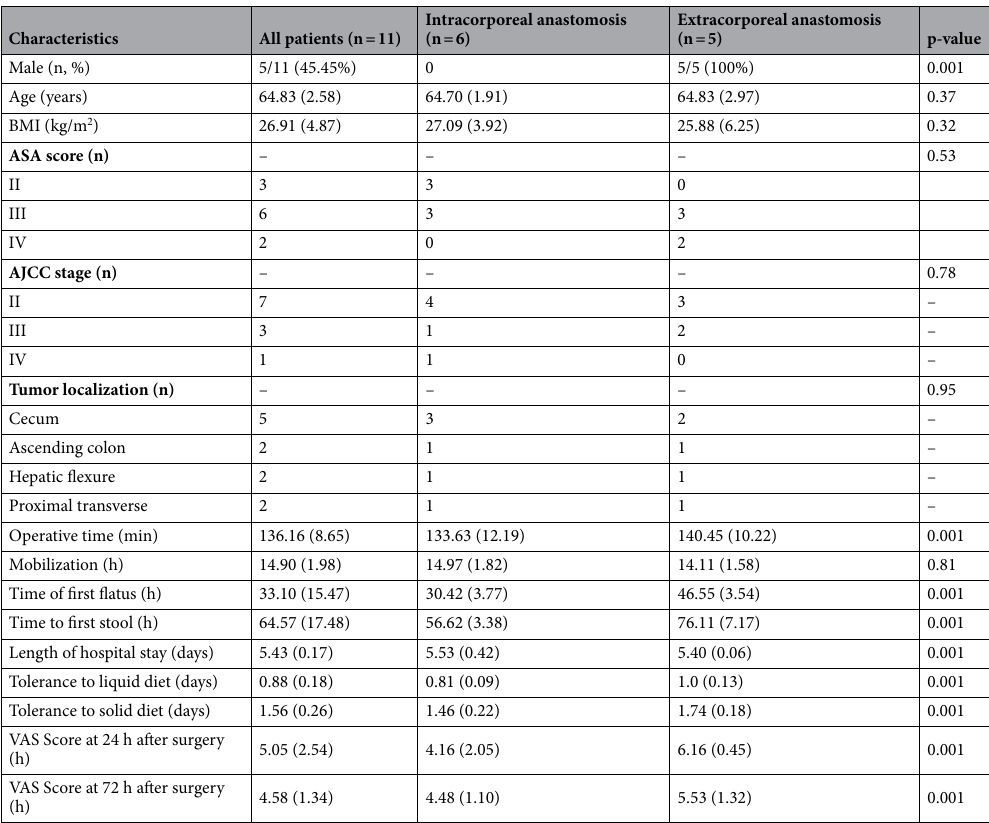
Table 5. Demographic characteristic and recovery outcomes of patients with post-operative complications. Data were expressed as median (interquartile range) where not differently indicated. BMI body mass index, ASA American Society of Anesthesiologists, AJCC American Joint Committee on